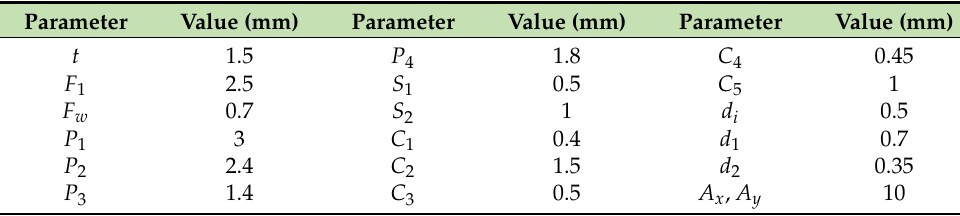
Table 1. Optimized dimensions of the proposed CP ME dipole antenna.